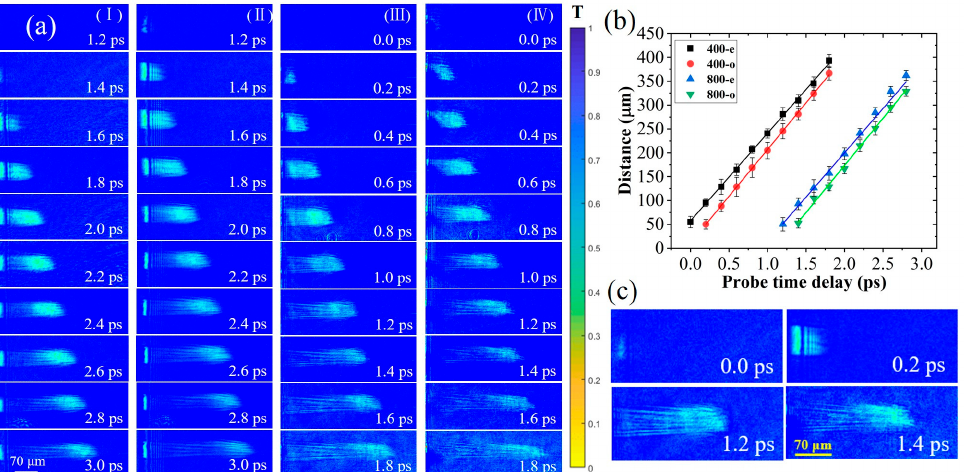
Figure 5. Time evolution of plasma filaments in fused silica induced by a femtosecond pulse laser. ( a ) Plasma images under four sub-pulses at ( I ) 800-o, ( II ) 800-e, ( III ) 400-o, and ( IV ) 400-e. The 0.0 ps was the time delay between the 400-e and the pump pulse. The images within 1.2 ps of the 800-o and 800-e were omitted because they did not detect any plasma information. ( b ) The propagation distance of the plasma front is observed by the four sub-pulses. ( c ) Plasma propagation is observed by a single shot.